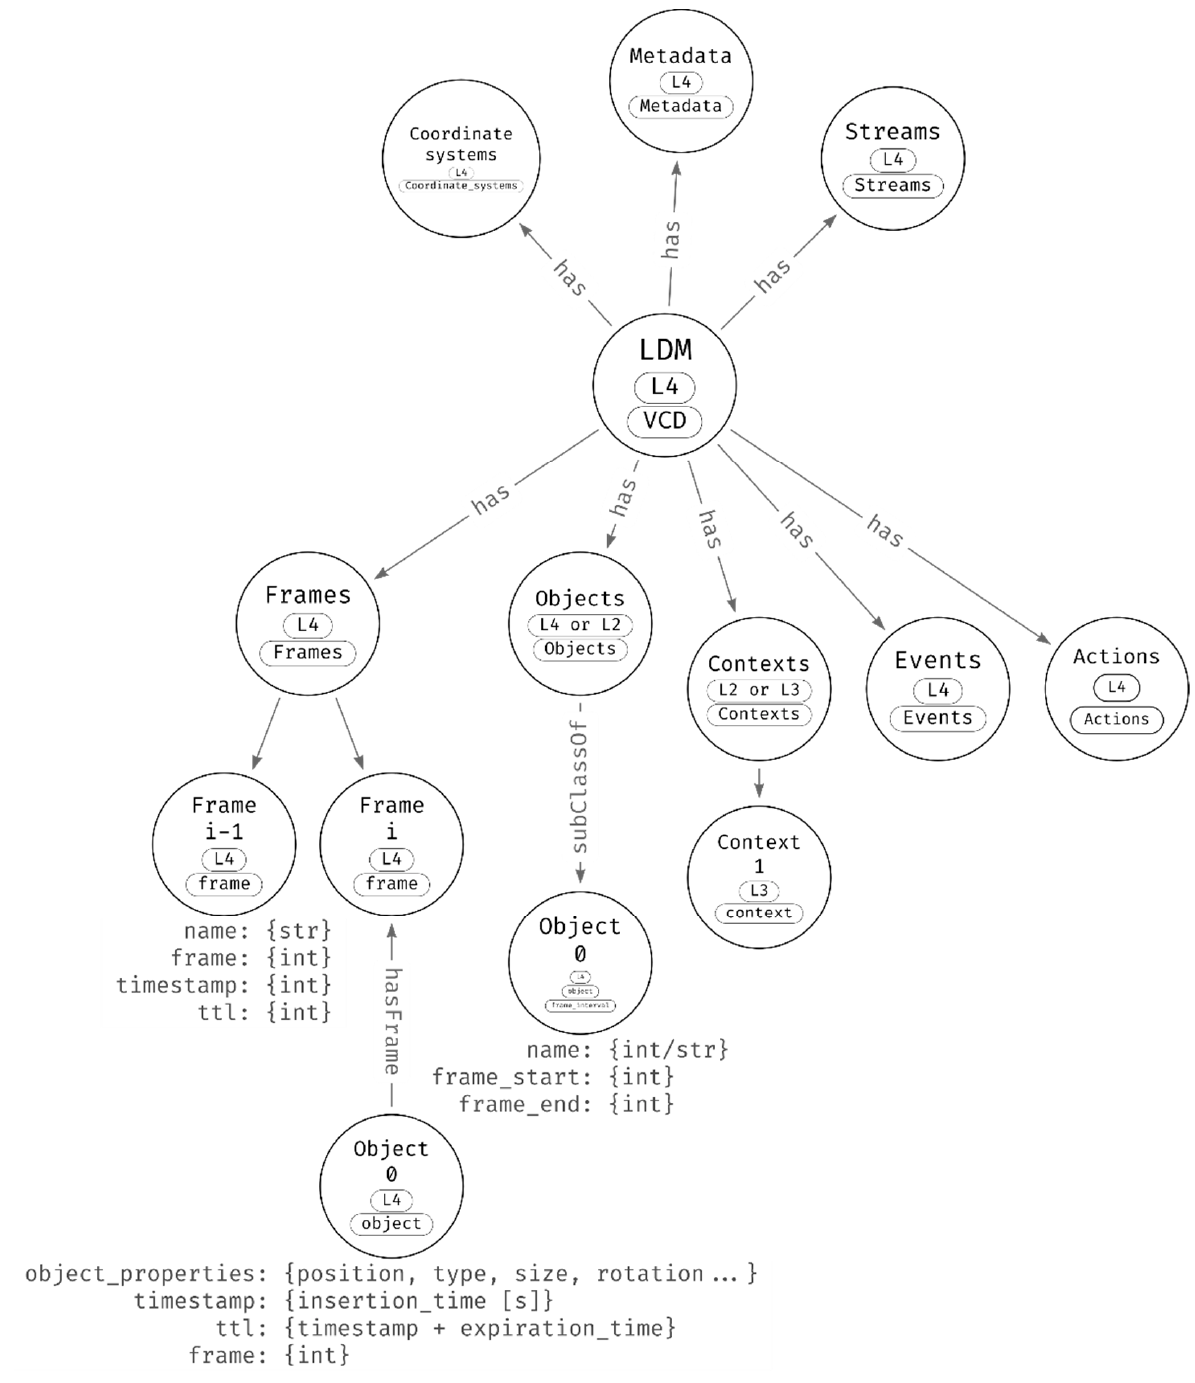
Figure 3. Dynamic layer (L4) data model graph representation.